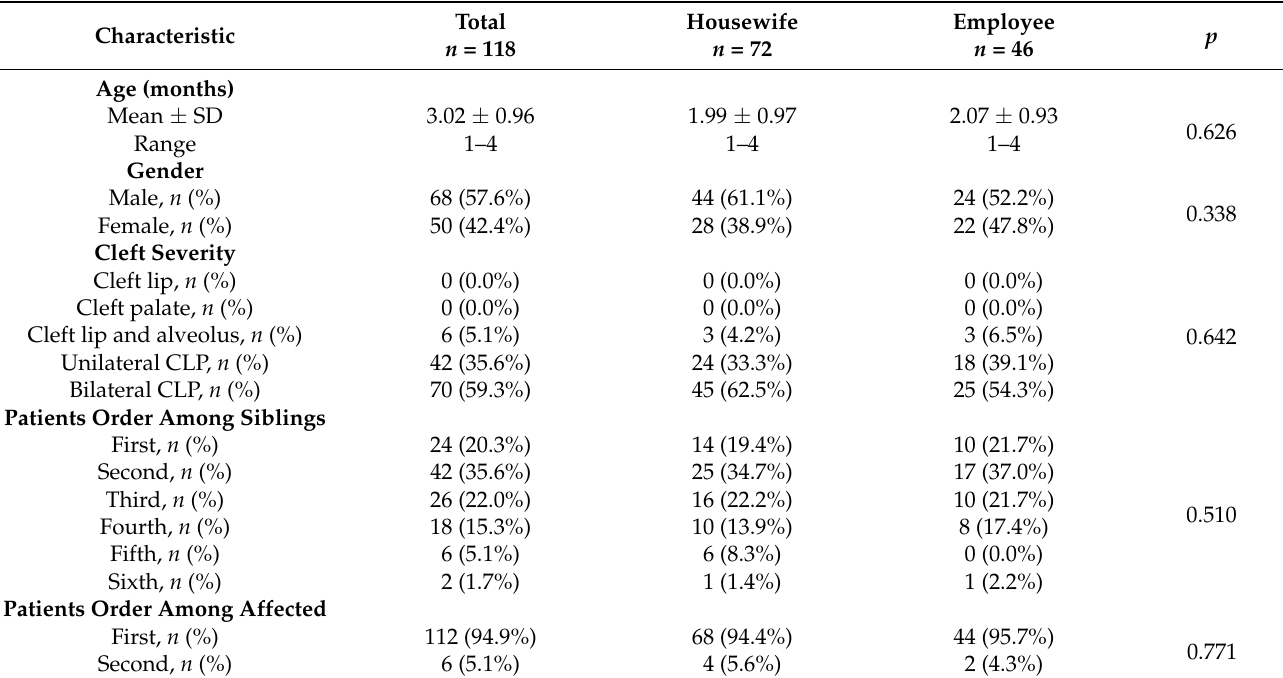
Table 1. The primary characteristics of infants diagnosed with CLP, with a reference to their